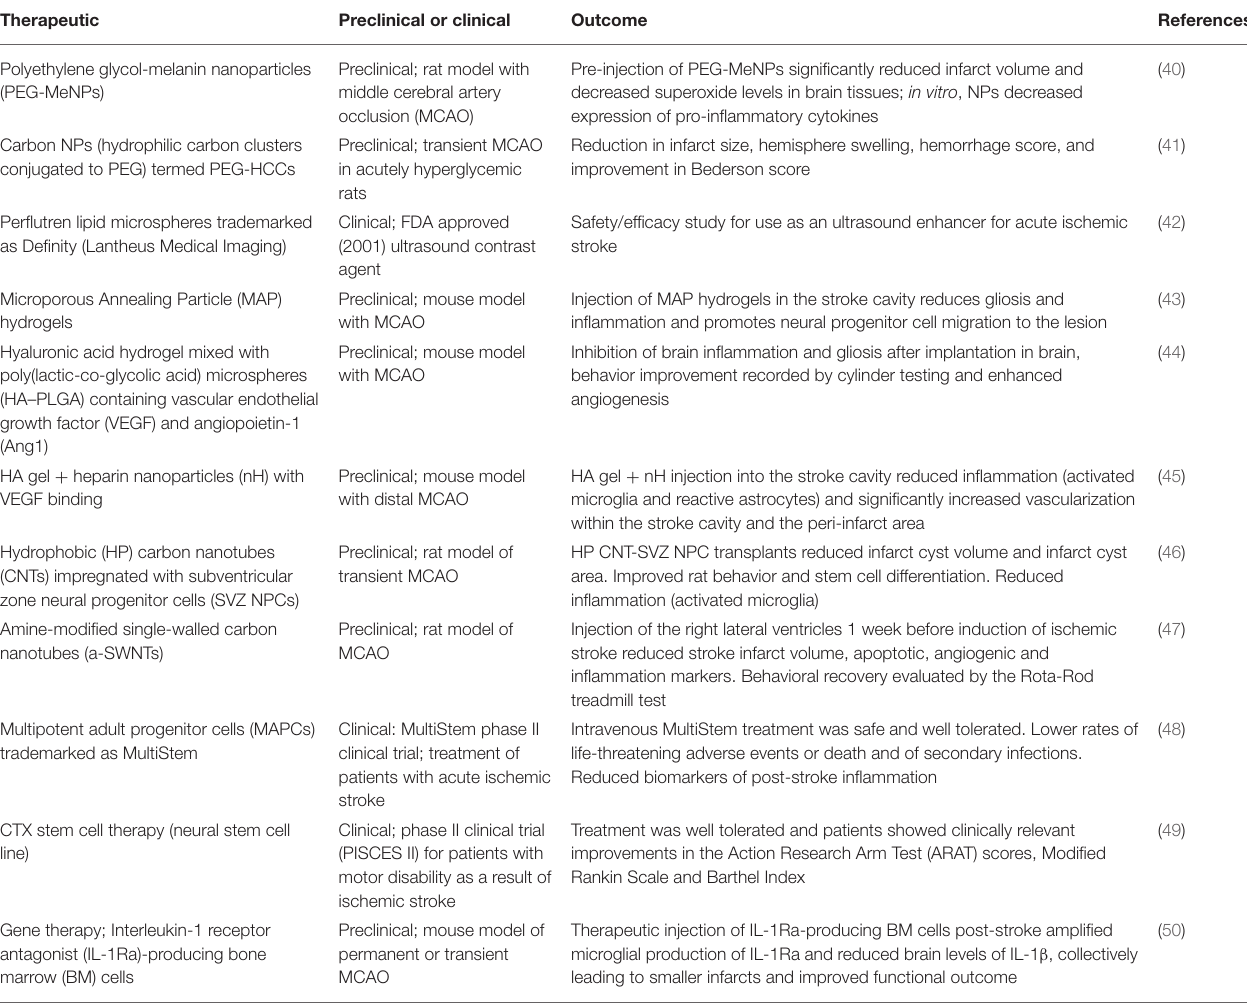
TABLE 1 | Regenerative medicine therapies for ischemic